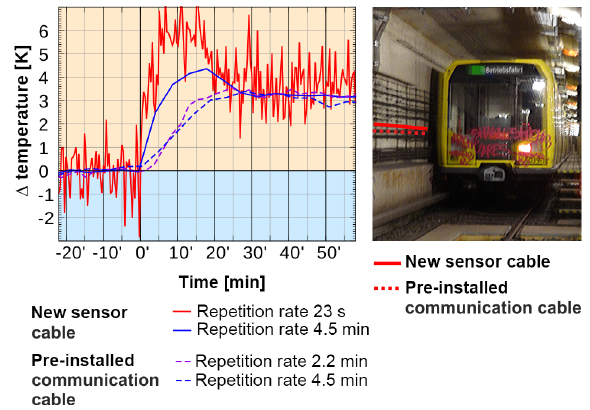
Figure 4. Short time response of temperature changes due to the parking of a train close to the tunnel walls with different sample rates. The blue lines represent the observed values on the same date (6 September 2016). The spatial resolution was set to 5m.